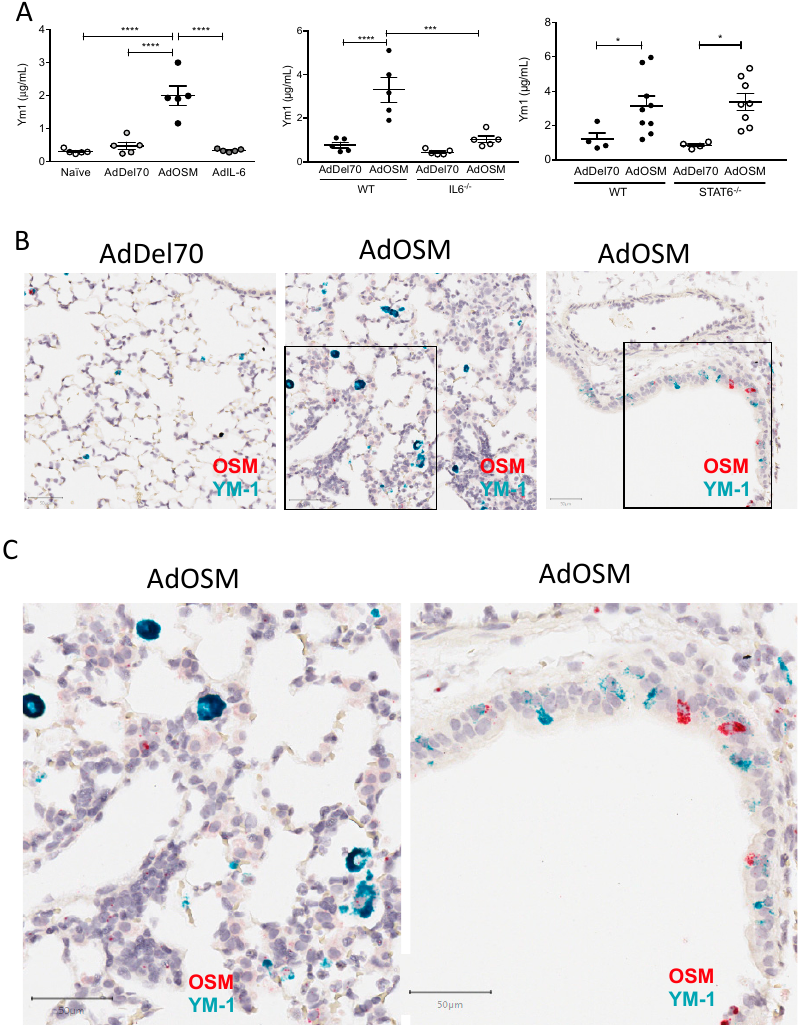
Figure 5. Induction of total lung YM-1 protein and YM-1 mRNA in situ by AdOSM. ( A ) YM-1 protein levels in total lung homogenates at day 7 post-treatment with AdDel70, AdOSM or AdIL-6 in wild-type, IL-6 - / - or STAT6 - / - mice (as indicated) assessed by ELISA. Data are expressed as mean ± SEM ( n = 4–6 mice / group). Statistical significance determined by one-way ANOVA with Tukey’s post hoc test (left panel) or by two-way ANOVA with Bonferroni’s post hoc test (right panels) (* p < 0.05, *** p < 0.001, **** p < 0.0001 between indicated groups). ( B ) Representative images are shown of CISH for YM-1 (green-blue) and OSM (red) in formalin-fixed para ffi n-embedded lung tissue sections from mice 7 days after treatments as indicated. ( C ) Higher magnification images of boxed regions in B from AdOSM-treated mouse lungs of wild-type mice. Scale bars, 50 µ